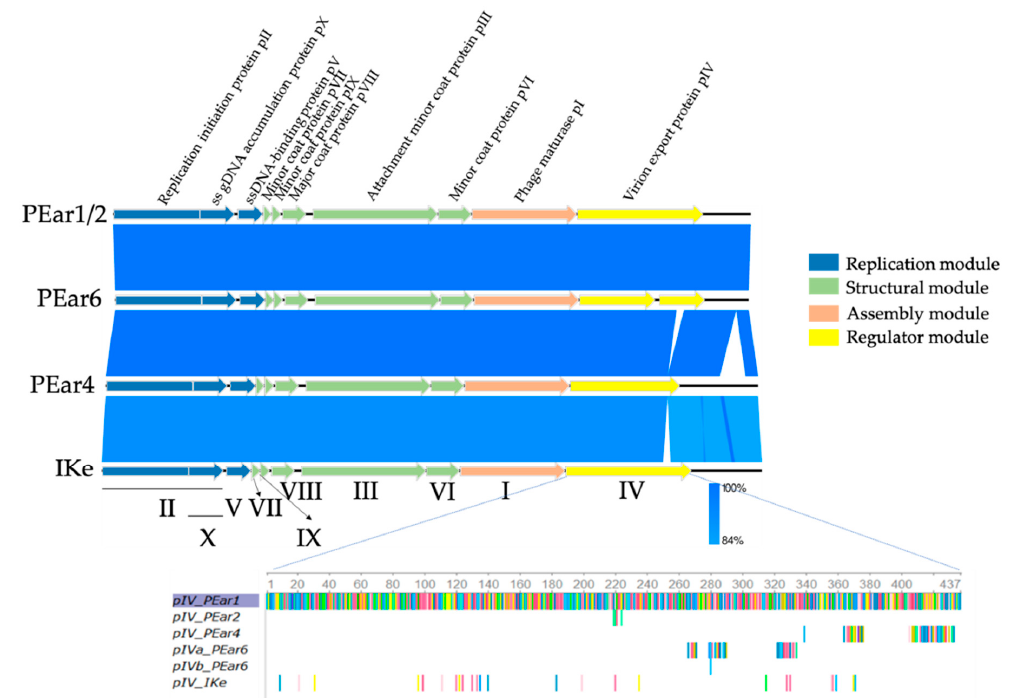
Table 2. Overview of the non-synonymous SNPs of PEar2 compared to PEar1 as determined with iVar [36]. The frequency of the specific mutation is given as well as the e-value. Mutations are located in the gene encoding pIV and cluster together in one region inside the amino acid sequence.